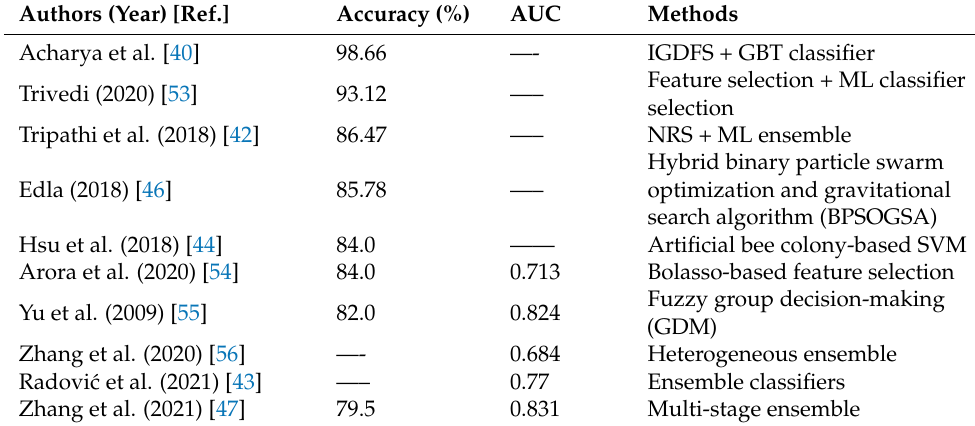
Table 3. Accuracy and area under the receiver operating characteristic curve (AUC) values of hybrid and ensemble classifiers for the German (categorical) dataset.